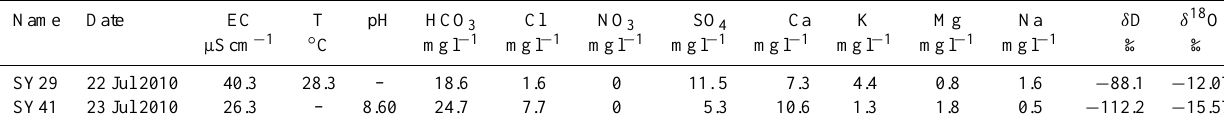
Table 3. Major ions and stable isotope concentrations in rain water in July 2010.